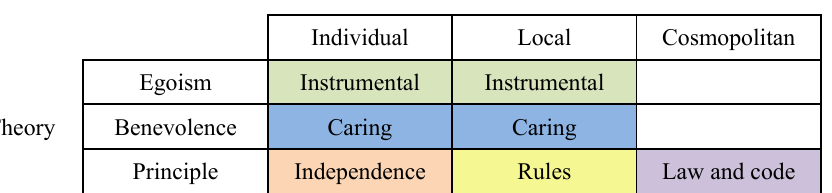
Fig. 2. Five common empirical derivatives of ethical climate (Victor, Cullen 1987, 1988)